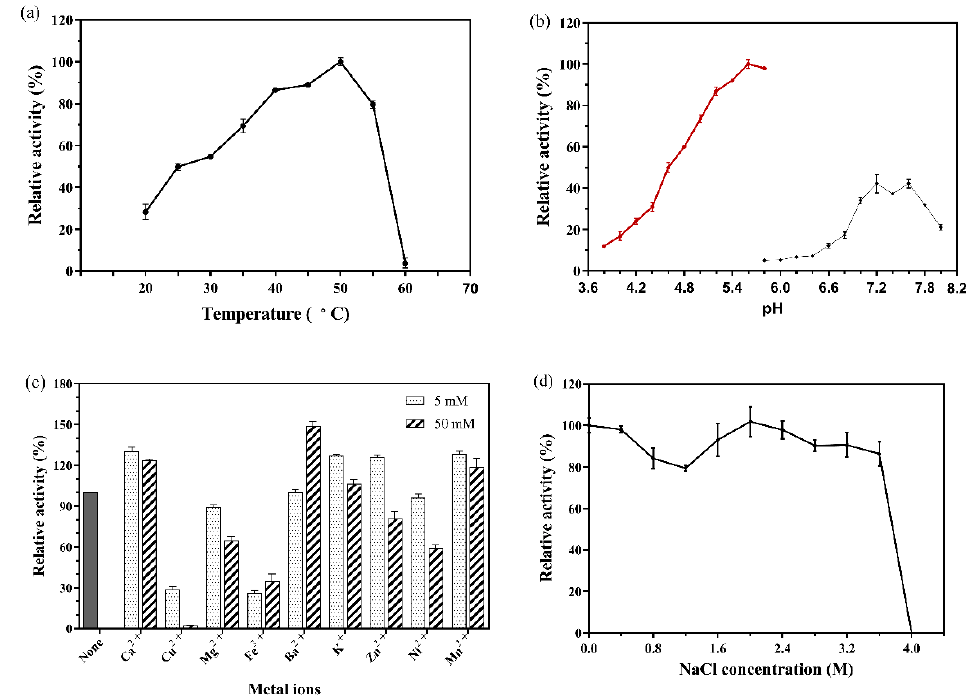
Figure 4. Enzymatic properties of the recombinant BM-2 levansucrase-Acma. ( a ) The effect of temperature. ( b ) The effect of pH on the catalytic activity. Two different buffer systems were used in the analysis: sodium acetate buffer (pH 3.8–5.8) and sodium phosphate buffer (pH 5.8–8.0). ( c ) The effect of various metal ions (5 mM, 50 mM). ( d ) The effect of NaCl concentration.